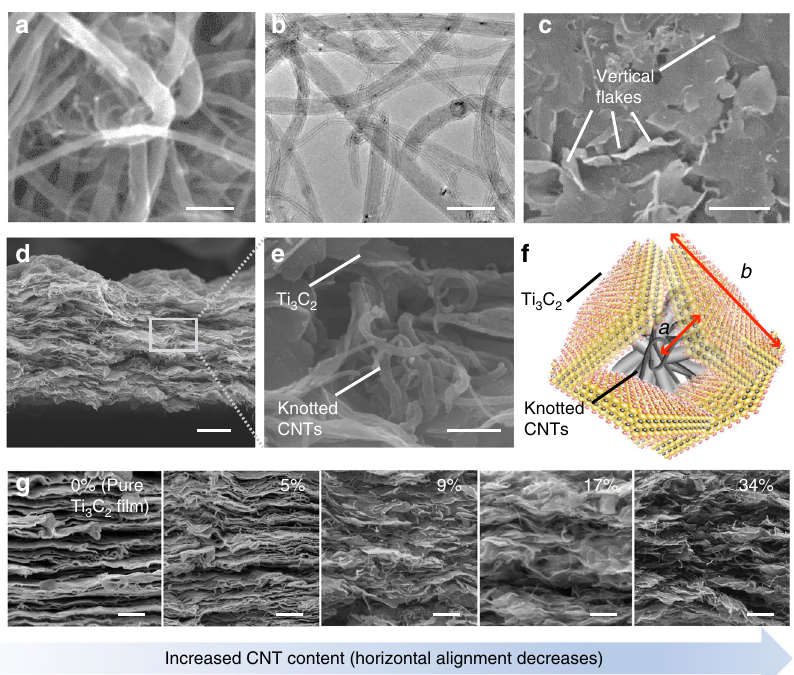
Fig. 2 Characterization of the knotted CNTs and MXene-knotted CNT composite electrodes. a SEM and b TEM images of the knotted CNTs. c Top view and d cross-sectional SEM images of an MXene-knotted CNT composite electrode with 17% CNTs. e SEM image and f corresponding schematic of how the alignment of the Ti 3 C 2 fl akes was broken by the knotted CNTs to form 3D networked structure. “ a ” and “ b ” (~1:2 ratio) in the schematic correspond to the radius of the knots (taking the knots as circles) and the size of the Ti 3 C 2 fl akes, respectively. g Cross-sectional SEM images of MXene-knotted CNT composite electrodes with different CNT contents from 0% (pure Ti 3 C 2 fi lm) to 34%. Scale bars, 100 nm ( a , b ), 1 μ m ( c , g ), 2 μ m ( d ), 200 nm ( e